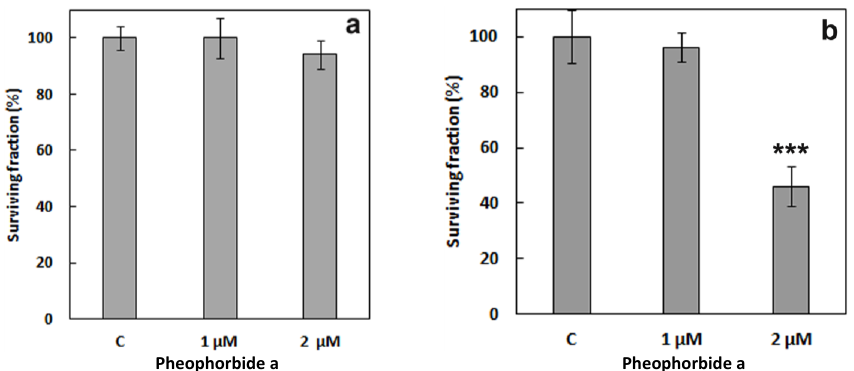
Figure 11. Viability of HeLa cells treated with PhA at different concentrations and non-treated control cells (c) for 4 h in the dark ( a ) and after irradiation ( b ). *** p < 0.001. SD is the average of at least three experiments.